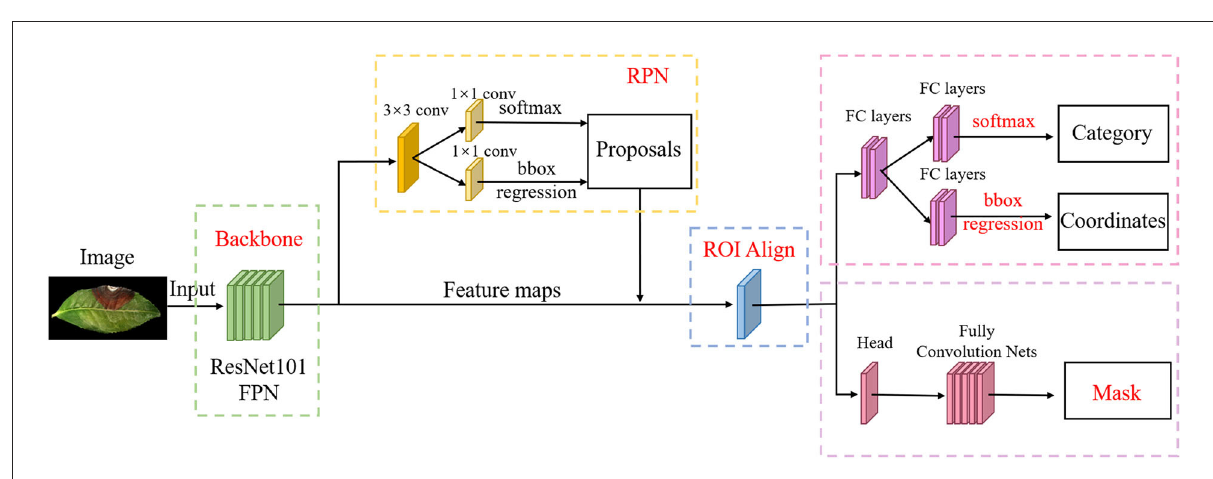
FIGURE4 Structure of Mask